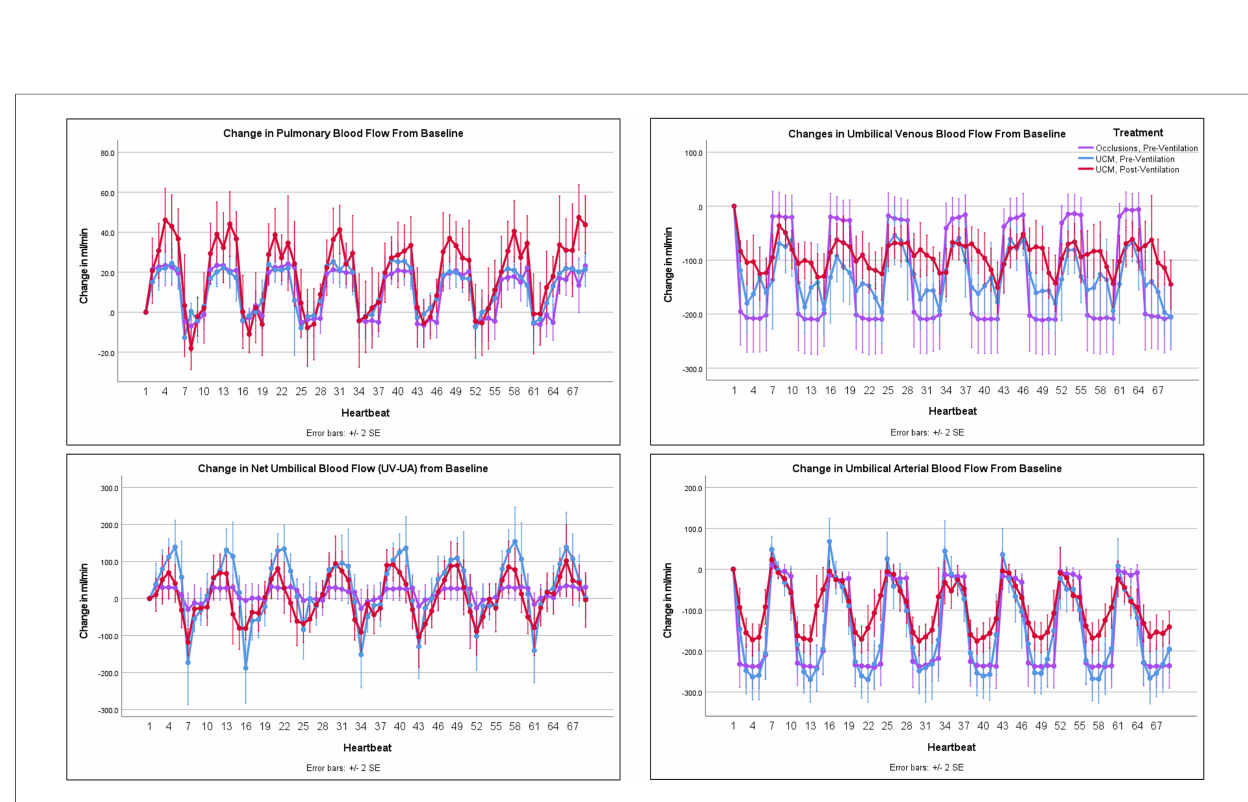
FIGURE 3 Change in pulmonary and umbilical blood fl ow with occlusions and umbilical cord milking (UCM): changes in pulmonary and umbilical blood fl ow from baseline during umbilical cord occlusions pre-ventilation, UCM pre-ventilation, and UCM